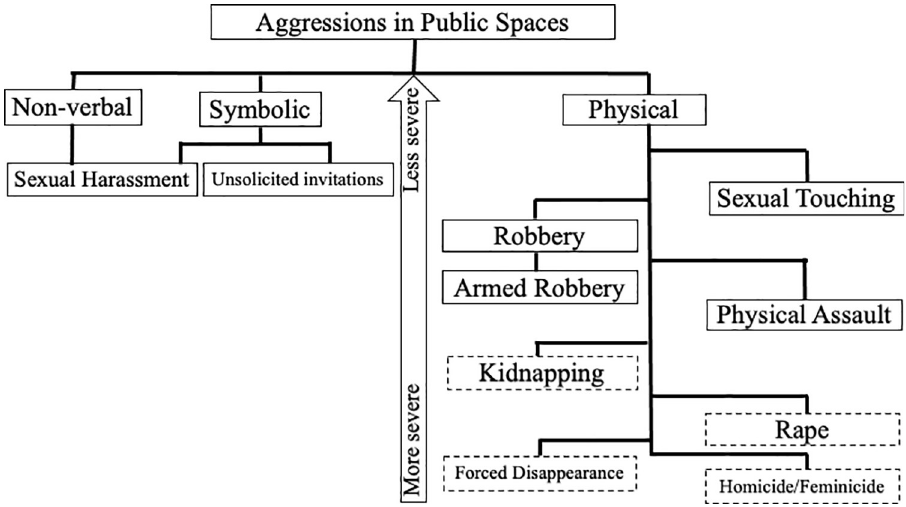
Fig 1. Aggressions in public spaces: School, neighbourhood and other areas of the city. Source: Own elaboration. Note 1: Sexual harassment was the only type of aggression that was also manifested nonverbally, primarily through leering, waiting, catcalling, exhibitionism, masturbating, and following. Note 2: Dashed lines indicate aggression experienced indirectly. Some participants suffered kidnapping attempts.